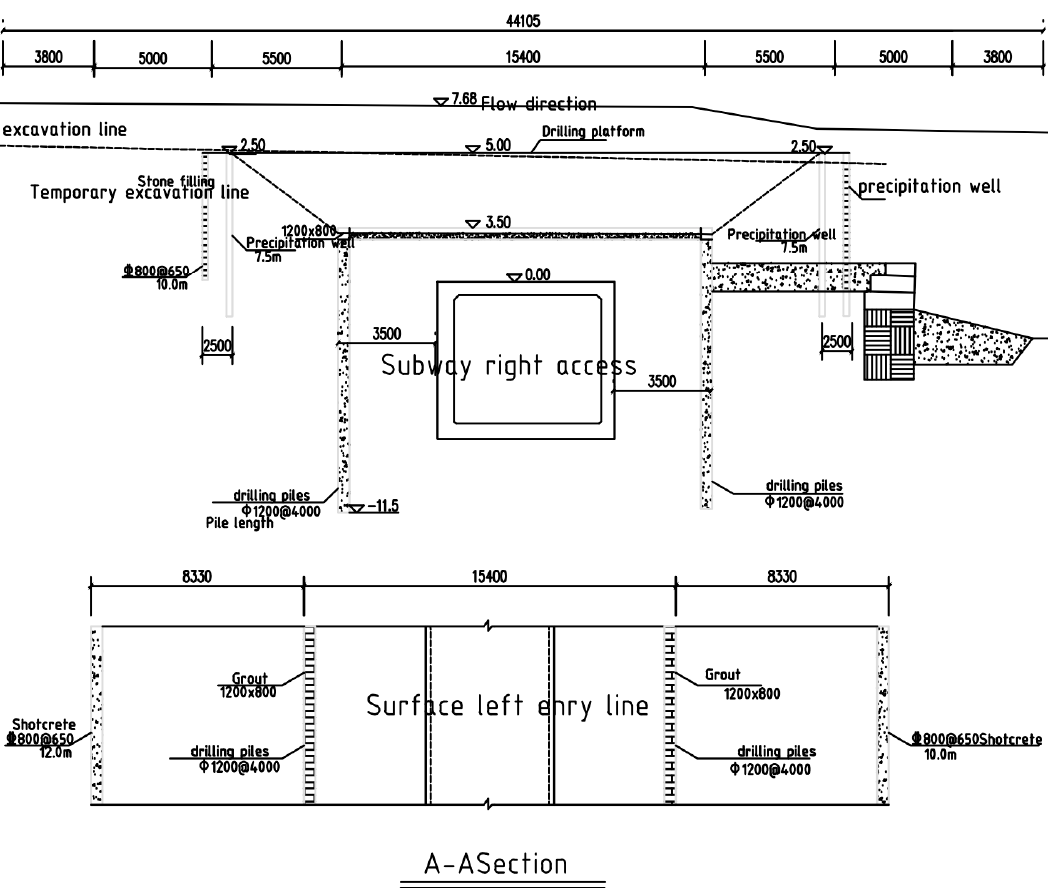
Figure 5. Anti-uplift protection measures for the right